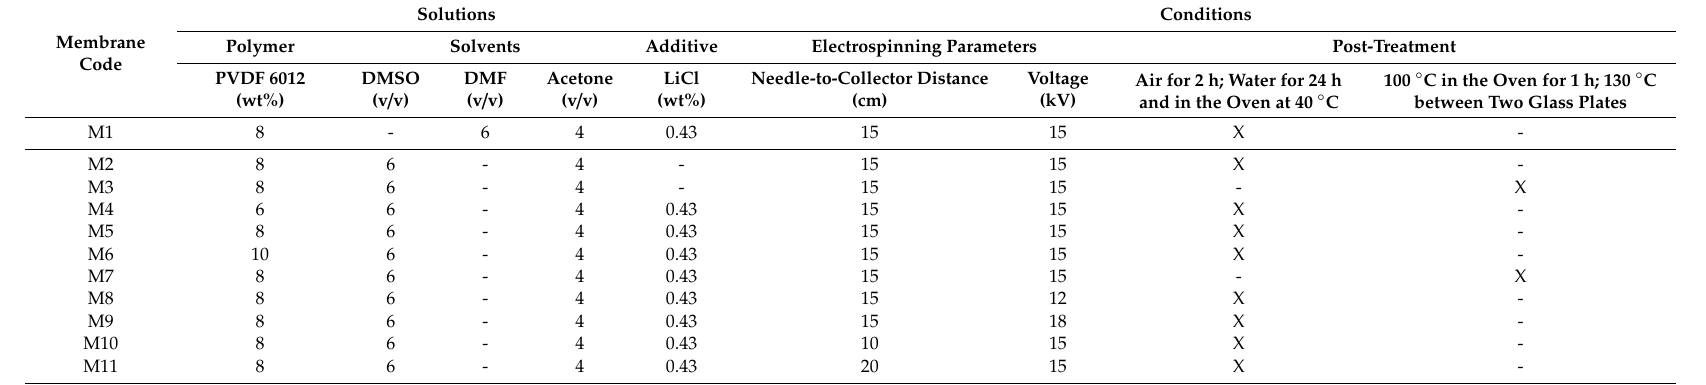
Table 1. Electrospun fiber membranes (ENMs) produced by